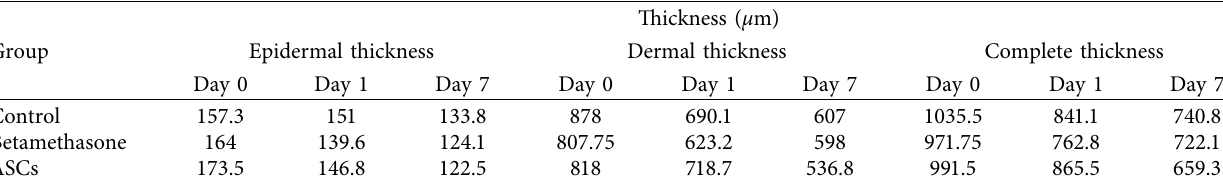
Table 3: Percentage of density in epidermis, dermis, and complete skin in control, betamethasone, and treatment with ASC extract on days 0, 1, and 7 ( p ≤